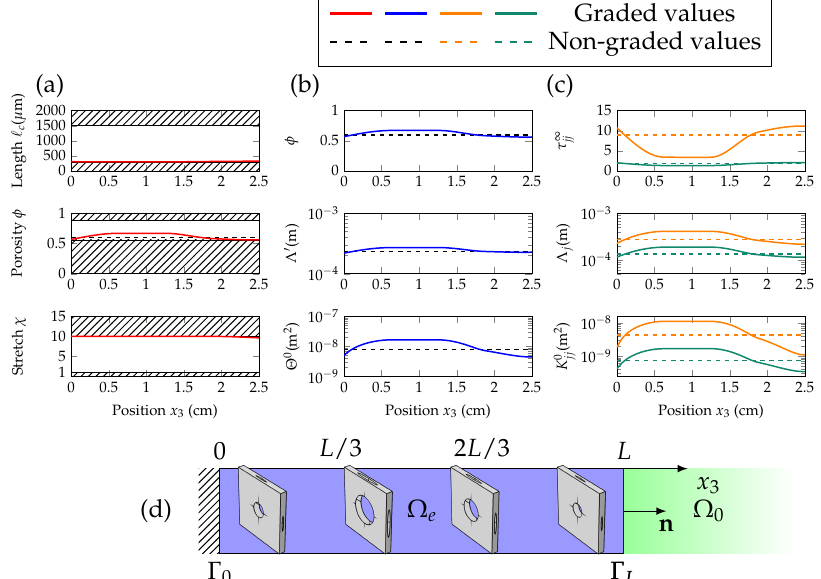
Figure 6. Components of the vector of geometric parameters W g (characteristic length (cid:96) c , porosity φ and stretch χ ) are shown in ( a ), as a function of the position x 3 . Scalar JCAL parameters ( φ , Θ 0 , Λ (cid:48) ) are given in ( b ) and the direction-dependent ones ( τ ∞ ⊥ , τ ∞ , K 0 ⊥ , K 0 , Λ ⊥ , Λ 3 ) are in ( c ), with respect to x 3 . 33 33 The graded values are in solid lines, and the non-graded ones in dashed lines; in orange for the normal direction, and in green for the transverse direction. The sketch in ( d ) displays snapshots of the unit cells at intervals of L /3 between interfaces Γ 0 and Γ L